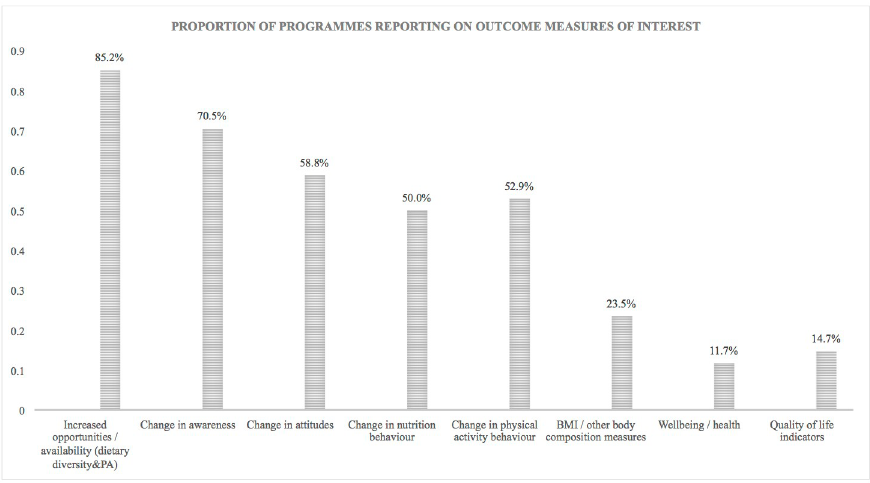
Fig 4. Proportion of programmes reporting on outcome measures of